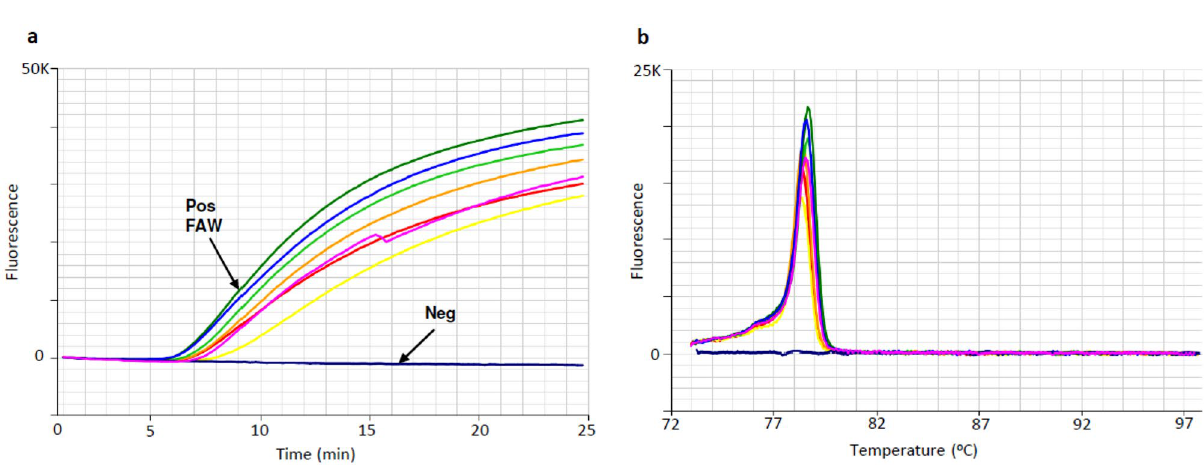
Figure 3. Optimised LAMP assay performed on FAW larva and adult moth laboratory DNA extracts. ( a ) Amplification profile, with 7 positive samples amplifying in approx. 10 min and negative sample (dark blue) showing a flat line. ( b ) Anneal derivative of LAMP amplicons, with an anneal derivative of 78.5